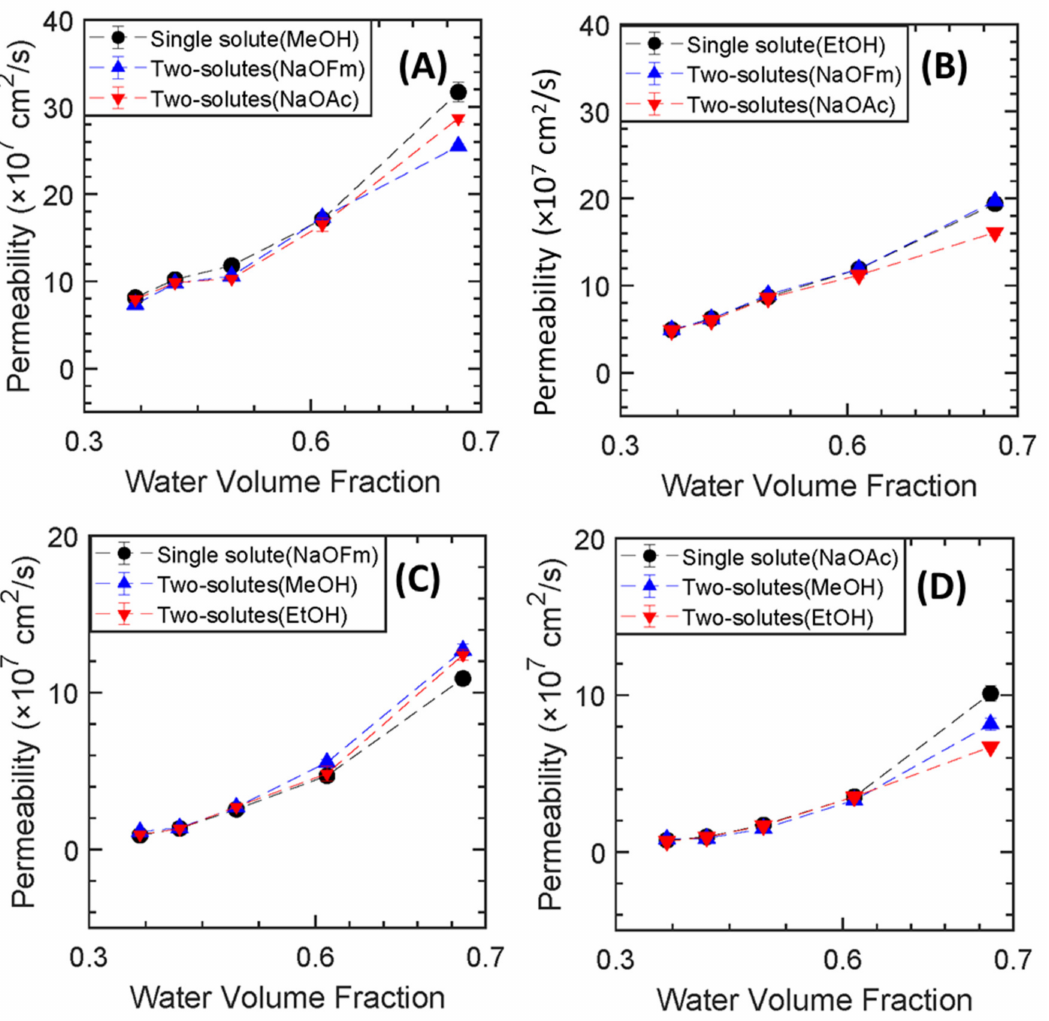
Figure 8. PEGDA-PEGMA permeability to ( A ) MeOH, ( B ) EtOH, ( C ) NaOFm, and ( D ) NaOAc in single and binary mixtures vs. water volume fraction for varied pre − polymerization water content at 32 mol%